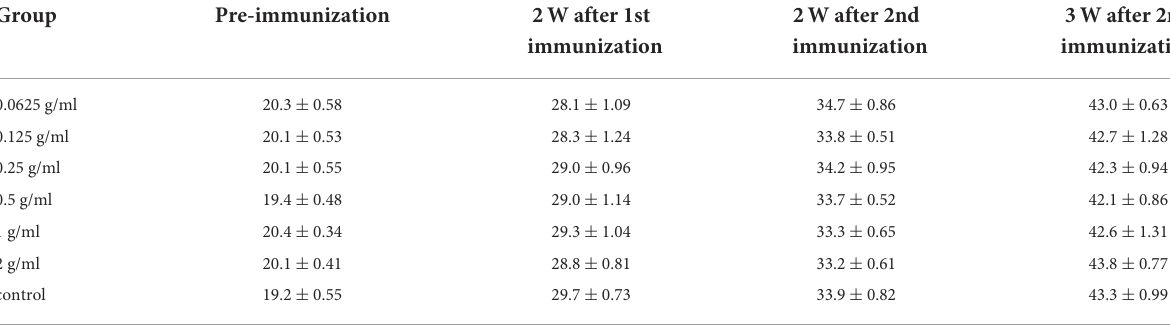
TABLE 2 Effect of oral administration of DBD on the mean body weight in mice ( n = 10). Group Pre-immunization 2W after 1st